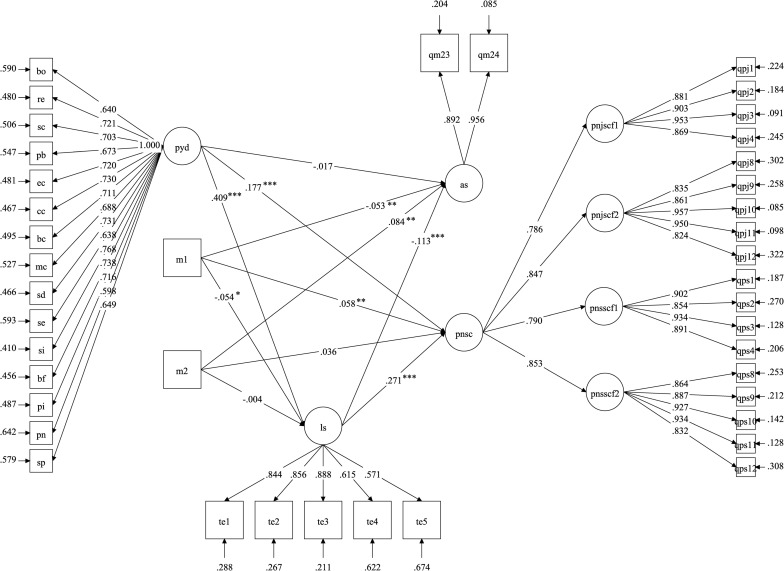
The structural equation model on the mediating effects of life satisfication on the influence of youth development qualities on academic satisfication and academic strees. ***p < 0.001;**p < 0.01;*p < 0.05. pyd = positive youth development qualities at Wave 1; Is = life satisfication at Wave 3; as = academic strees at Wave 6; pnsc = satisfication with new secondary school curriculam at Wave 6; pnjscf1, pnjscf2, pnsscf1, and pnsscf2 are four factors of pnsc; m1 and m2 are two convariates: m1 = age, m2 = gender. The factors loadings for each latent variable were estimated by fixing one factor loading (unstandardized) to 1.0. The factor loadings shown in figure are standardized factor loadings. The R-square values for the two endogenous variables: as and pnsc are 0.024 and 0 147, respectively.